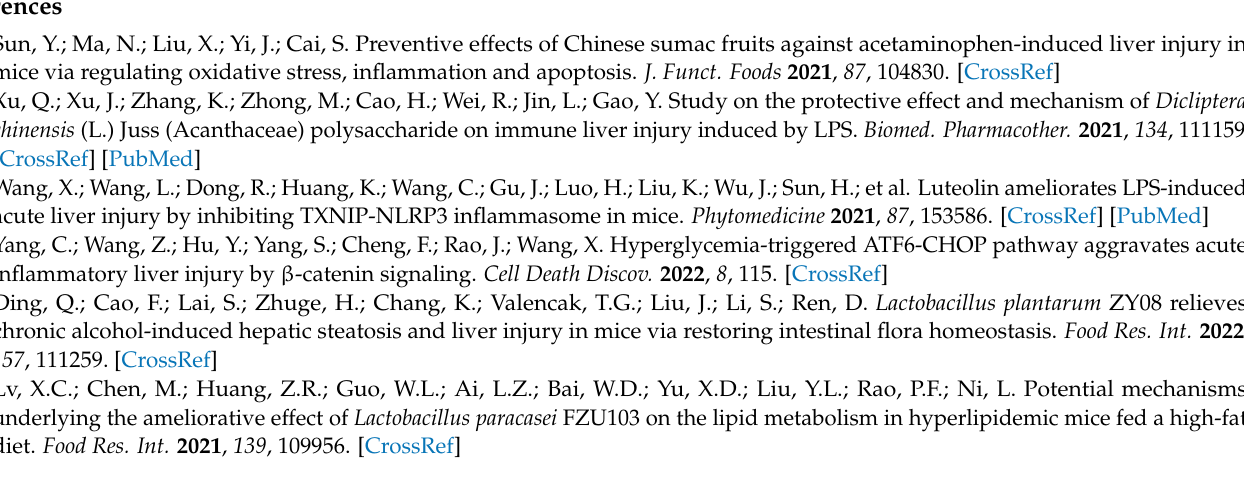
(n = 8); Figure S3: Effect of L. paracasei CCFM1223 on the serum TC, TG, HDL-C, and LDL-C levels in LPS-treated mice (n = 8); Figure S4: Hierarchical cluster analysis based on the genus level; Figure S5: Extended error bar plot identifying the intestinal microbiota of significant differences between NC and LPS groups; Figure S6: Heatmap of Spearman’s correlation analysis between the key intestinal bacterial phylotypes and parameters of ALI; Table S1: Primer sequences for quantitative real-time PCR of hepatic